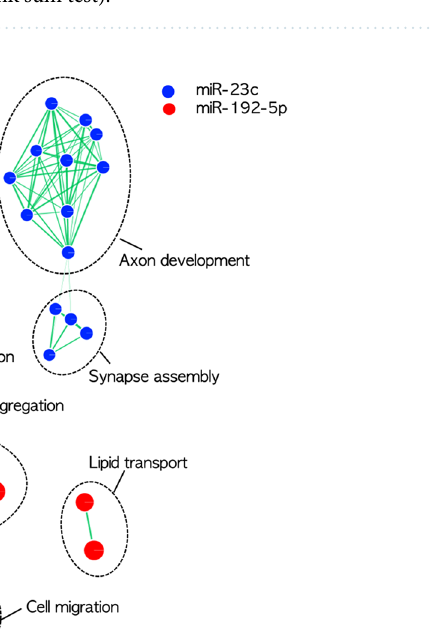
Figure 2. Differential expression of sEV miRNAs and the results of droplet digital PCR validation. Venn diagram ( A ) and heatmaps ( B ) showing the number and differential expression of miRNAs identified in a discovery set by each method (DESeq2, edgeR, and quantile normalization with independent t test). Expression values were normalized across all samples (columns: P, ALS patients; C, healthy controls) by Z-score, and miRNA clustering (row) was applied. ( C ) Quantification of levels of five miRNAs (commonly identified in the three analyses) by droplet digital PCR in a validation set. The amplified droplets were analyzed using Quantasoft software v1.7.4 (https:// www. bio- rad. com/ webro ot/ web/ pdf/ lsr/ liter ature/ 10047 467. pdf). Each bar indicates the relative mean quantity of each miRNA (normalized to miR-191-5p as an endogenous reference) compared to the average value in the healthy control. Error bars and asterisk (*) represent standard error of the mean and statistically significant difference (p < 0.05, Wilcoxon rank sum test).